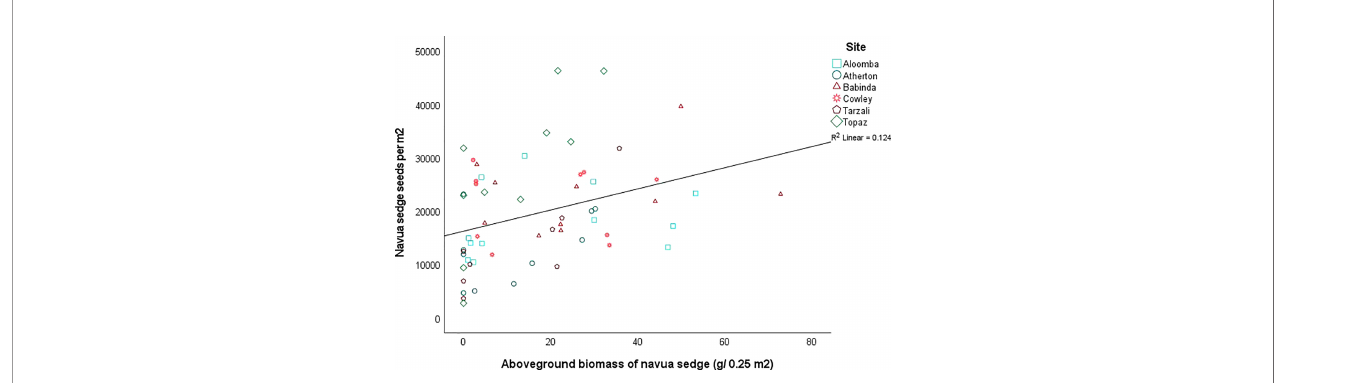
FIGURE 5 | Relationship between number of Navua sedge seeds present in the soil and aboveground biomass of the weed (y=1.62E4+1.98E2*x). N= 4-6 plots per site; For each of the site, data has been pooled across both high and low infestation plots and 0-5 and 5-10 cm soil